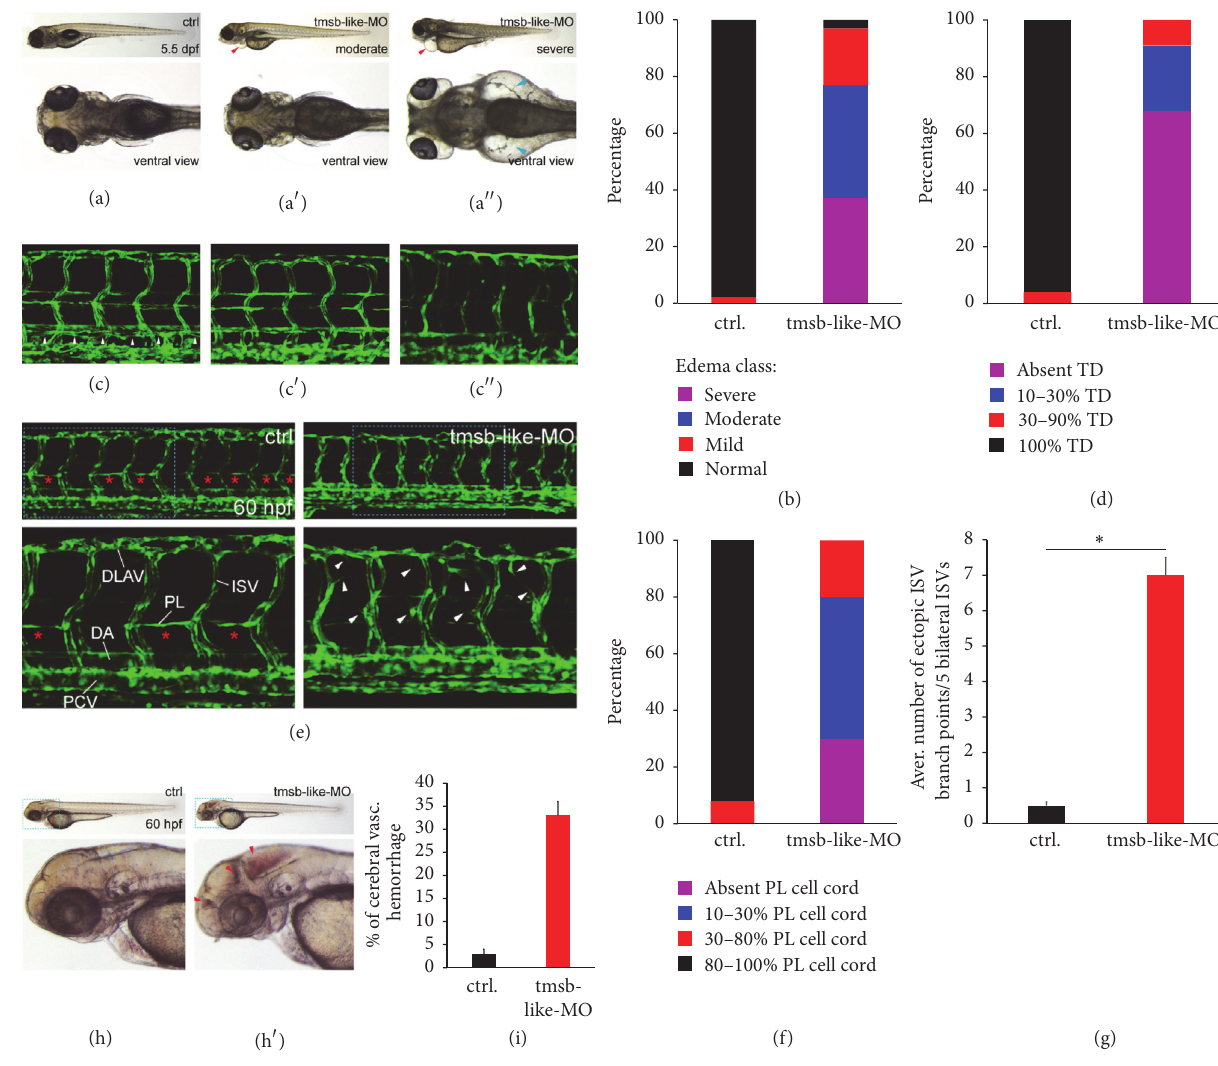
Figure 3: Effect of morpholino mediated tmsb-like knockdown in zebrafish. (a) Edema formation in zebrafish treated with tmsb-like-MO. Knockdown animals show moderate (a 󸀠 ) to severe (a 󸀠󸀠 ) edema formation compared to control ((a), arrowhead), which was quantified in (b) ( 𝑛 = 123 for control-MO and 114 for tmsb-like-MO). (c) Thoracic duct (TD) formation was blunted to a moderate (c 󸀠 ) to sever (c 󸀠󸀠 ) degree in tmsb-like-MO animals compared to proper TD formation in control animals 5.5 days postfertilization (dpf, (c), arrowhead). Results were quantified in (d) ( 𝑛 = 112 for control-MO and 103 for tmsb-like-MO). (e) Knockdown of tmsb-like leads to the aberrant formationofintersegmentalvessels(ISV)displayinganineffectivehypersproutingphenotype(arrowheads)andaperturbationofparachordal lymphatic vessel generation by parachordal lymphangioblasts (PL) 60hpf. (PCV: posterior cardinal vein, DA: dorsal aorta, and DLAV: dorsal longitudinal anastomotic vessel). (f) Presence of parachordal lymphangioblasts in 10 successive somites ( 𝑛 = 109 for control-MO and 118 for tmsb-like-MO) and (g) average number of ectopic ISV branch points in 5 bilateral ISV ( 𝑛 = 55 per group, ∗ 𝑝 < 0.05 ) demonstrate excessive branching and ineffective parachordal vessel formation in animals lacking tmsb-like. (h and i) tmsb-like-MO treated animals displayed a high rate of cerebral vascular hemorrhage compared to control-treated animals 60 hours postfertilization ( 𝑛 = 225 for control-MO and 204 for tmsb-like-MO, ∗ 𝑝 < 0.05